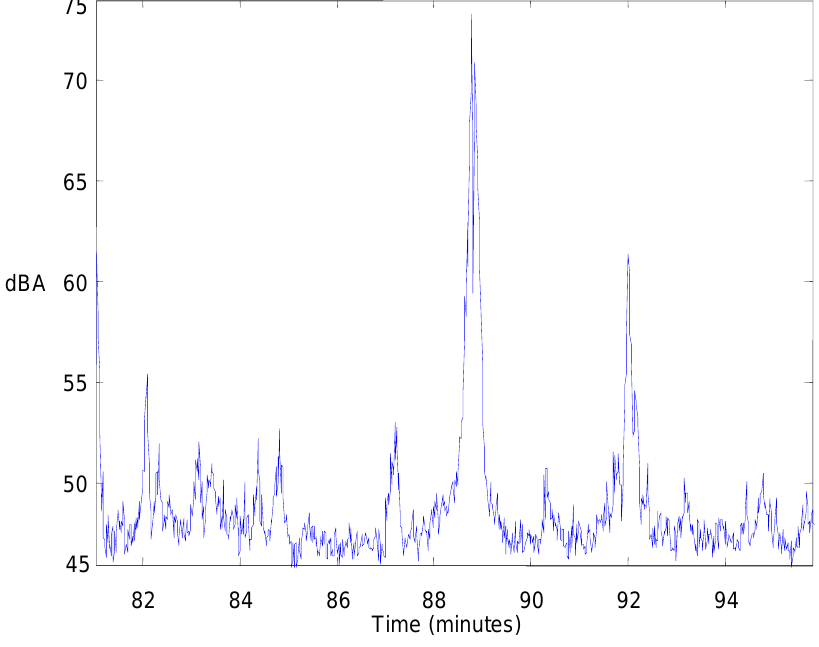
Figure 9. The highest peak of the A-weighting equivalent noise